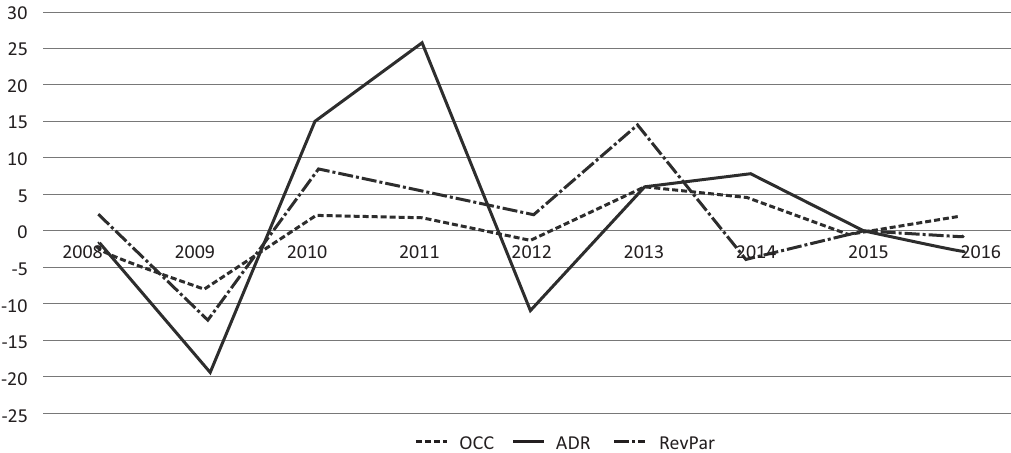
Source: compiled and completed by authors based on Marriott International Inc. (2009, 2010, 2013, 2016); NASDAQ